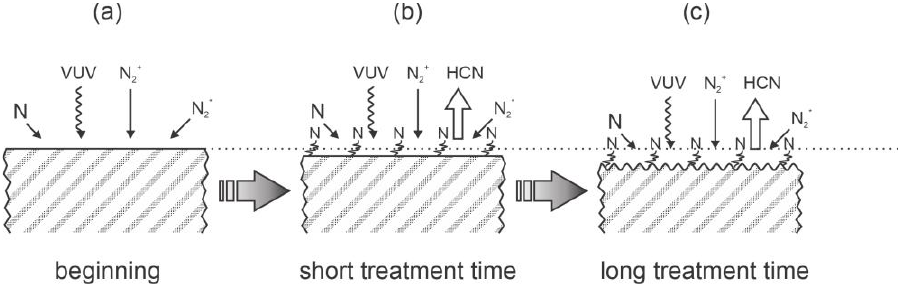
Figure 5. Schematic of the interaction between nitrogen plasma and PEEK surface at the beginning of treatment ( a ), after short ( b ) and long treatment time ( c ). treatment ( a ), after short ( b ) and long treatment time ( c